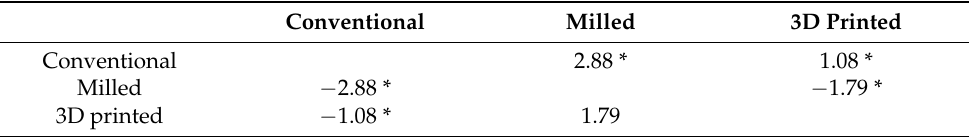
Table 3. Mean difference and One-way ANOVA between the three groups. Conventional Milled 3D Printed Conventional 2.88 * 1.08 * Milled − 2.88 * − 1.79 * 3D